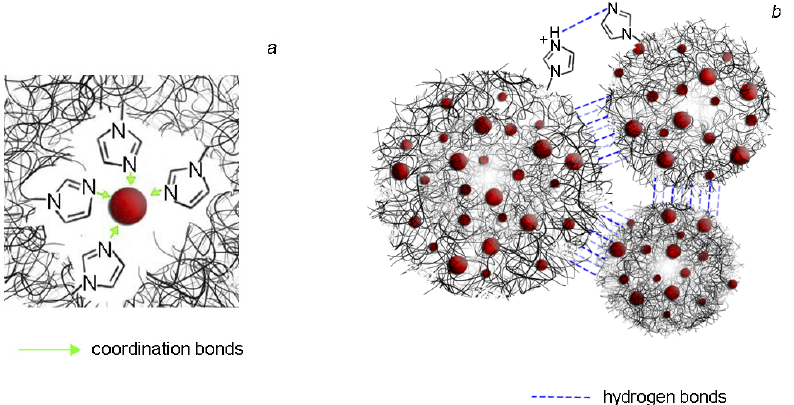
bonds ( b Figure 7. Stabilization of CuNPs by PVI ( a ) and association of nanocomposites by hydrogen bonds ( b ).